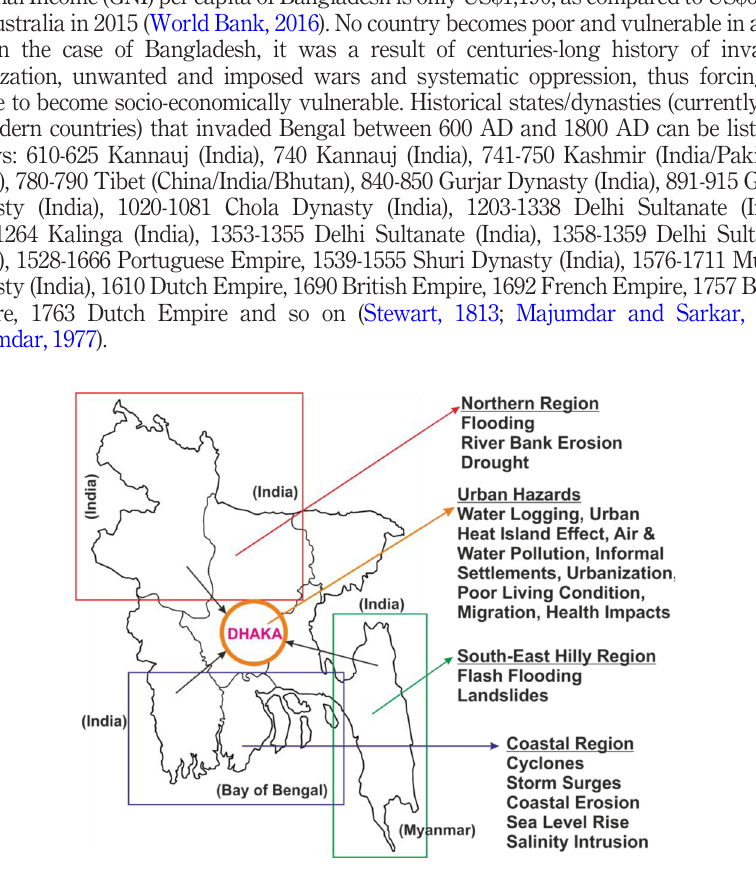
Figure 1. The frequently